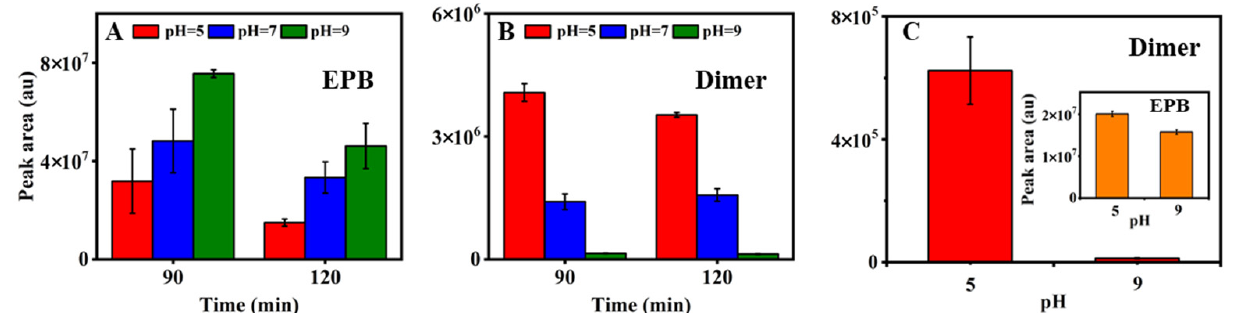
Figure 3. The remaining EPB peak area ( A ) and peak area of dimer ( B ) under different pH (pH = 5, 7, 9, 160 µM, 500 W). The peak area of the dimer under pH = 5, 9, 20 µM, 200 W ( C ); the inset showed peak area of remaining EPB.